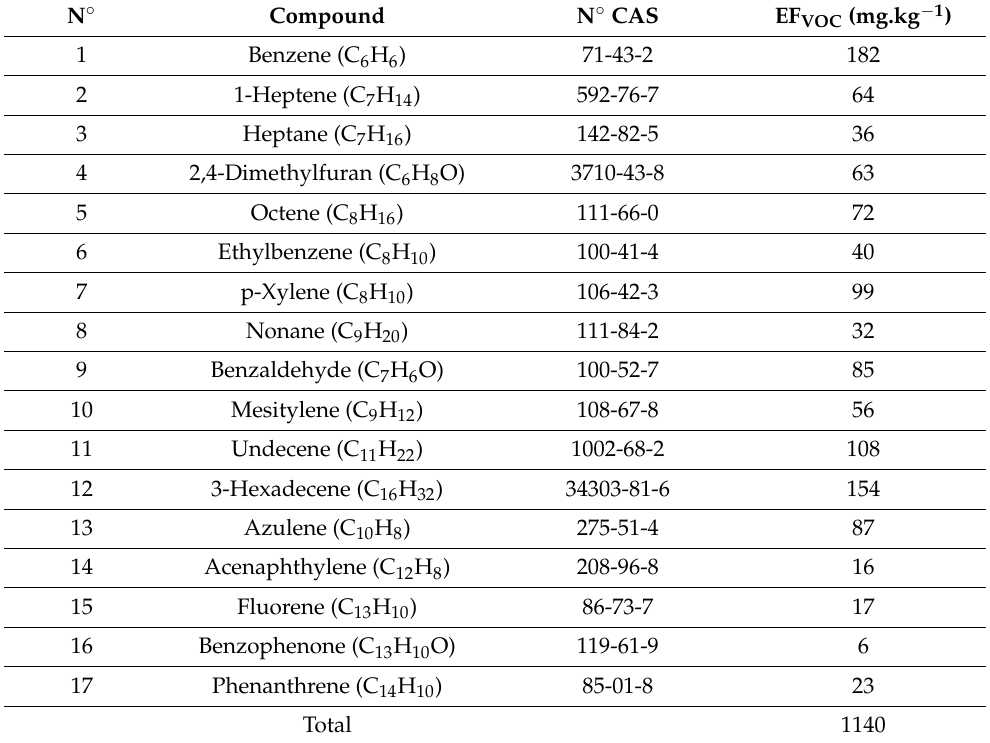
Table 5. EF for VOCs and SVOCs of thermoplastic